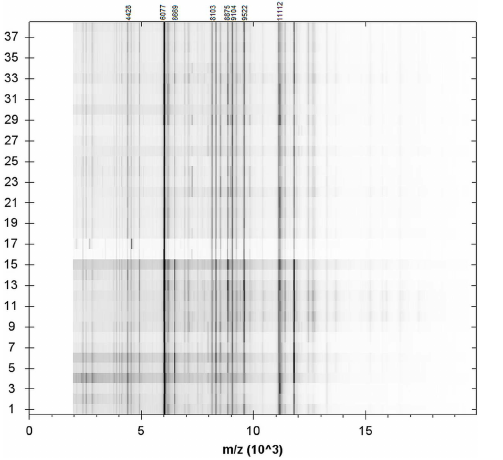
Fig 2. Pseudo gel view representation obtained from the averagemass spectraof E . faecalis .